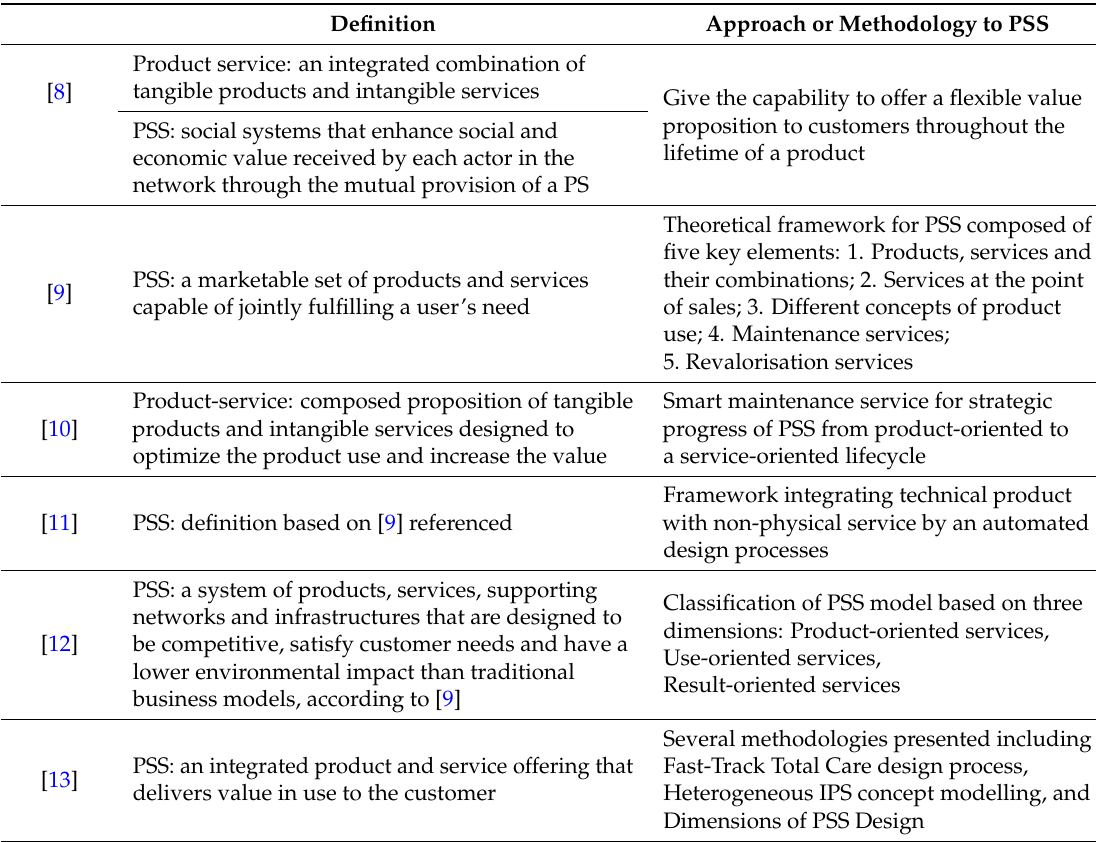
Table 1. Summary of Section 2.1. PSS, Product-Service